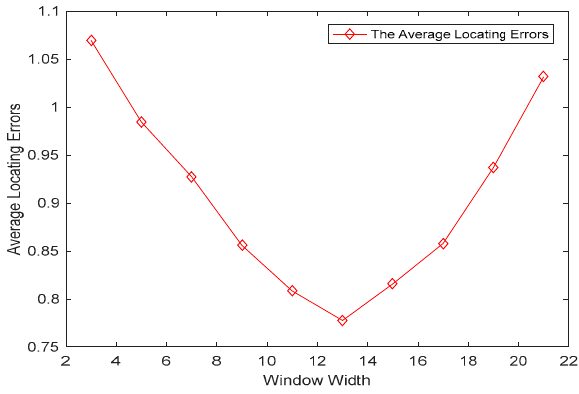
Figure 9. The average location error curve.